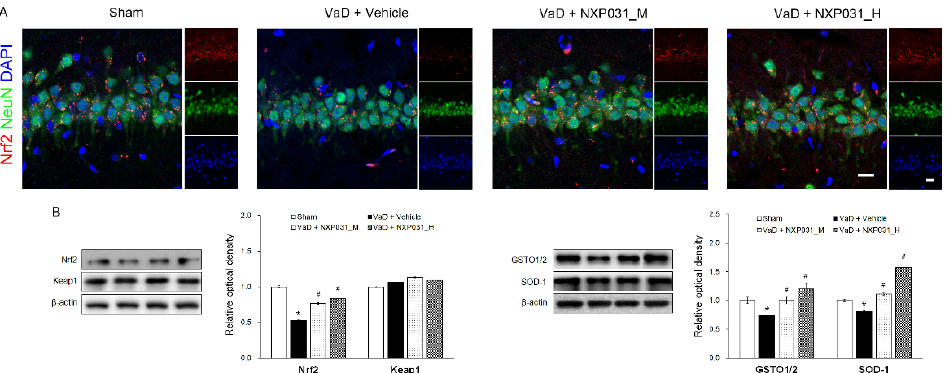
Figure 4. Effect of NXP031 on CCH-induced Nrf2 dysfunction in the hippocampus. ( A ) Representa- tive photographs of immunofluorescence staining of Nrf2 (red) and NeuN (green)-positive cells in the hippocampal CA1 region after CCH. ( B ) Representative bands of Nrf2, keap1, GSTO1/2, and SOD-1 protein expression in the hippocampus after CCH. The data are presented as the mean ± S.E.M. * p < 0.05 compared with the sham group. # p < 0.05, compared with the VaD group. Scale bar: 20 µ m.